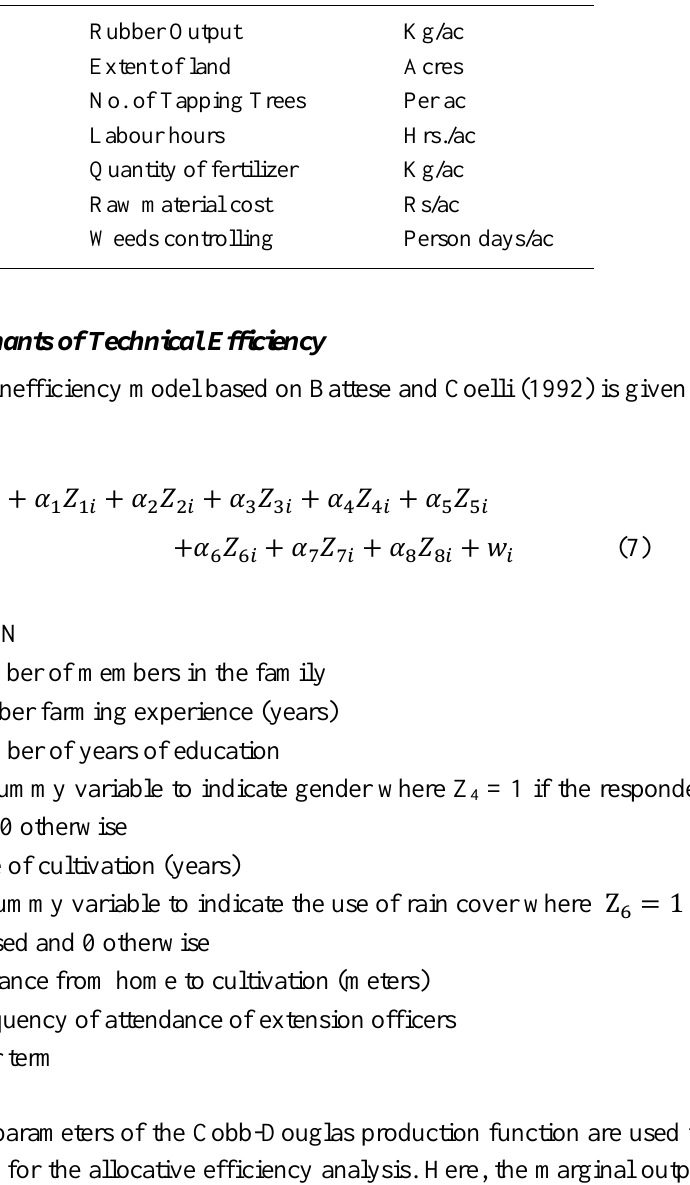
Table 2: Variable Definition and Units of Measurements Used for the Models